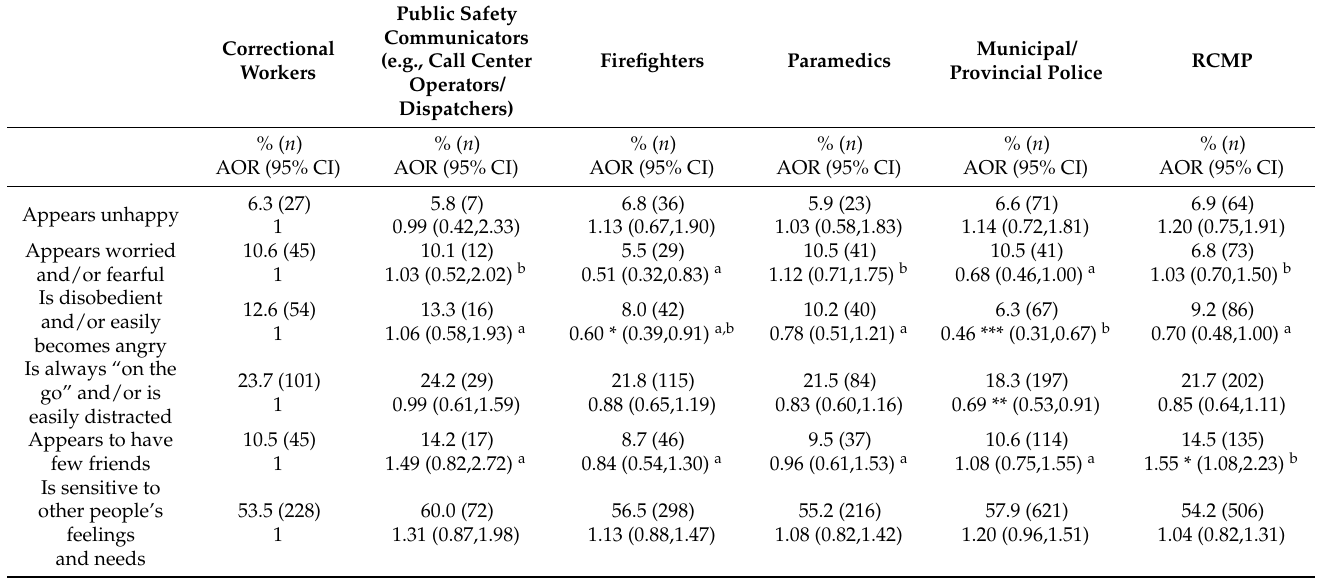
Table 3. Prevalence of Children Described as Very Characteristic or Entirely Characteristic for Well- Being Variables by Public Safety Personnel Type and Relationship Between Well-Being Variables and Public Safety Personnel